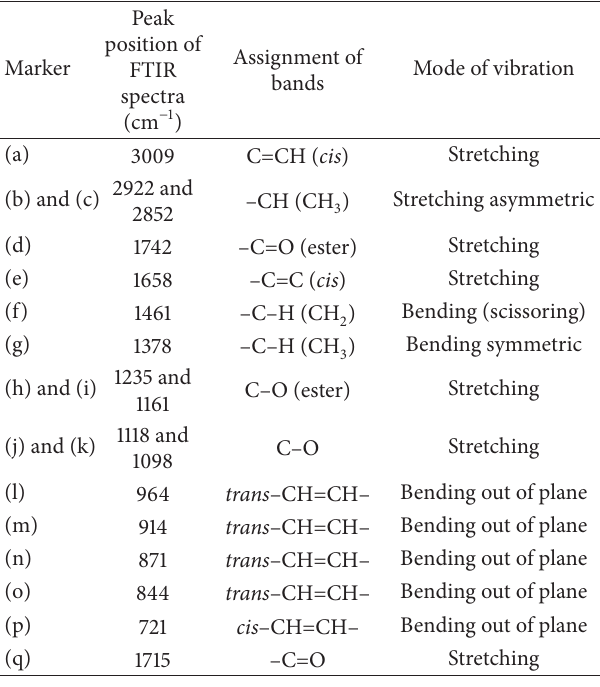
Table 1: Functional groups and mode of vibration from FTIR spec- tra of the evaluated oils [19, 20].